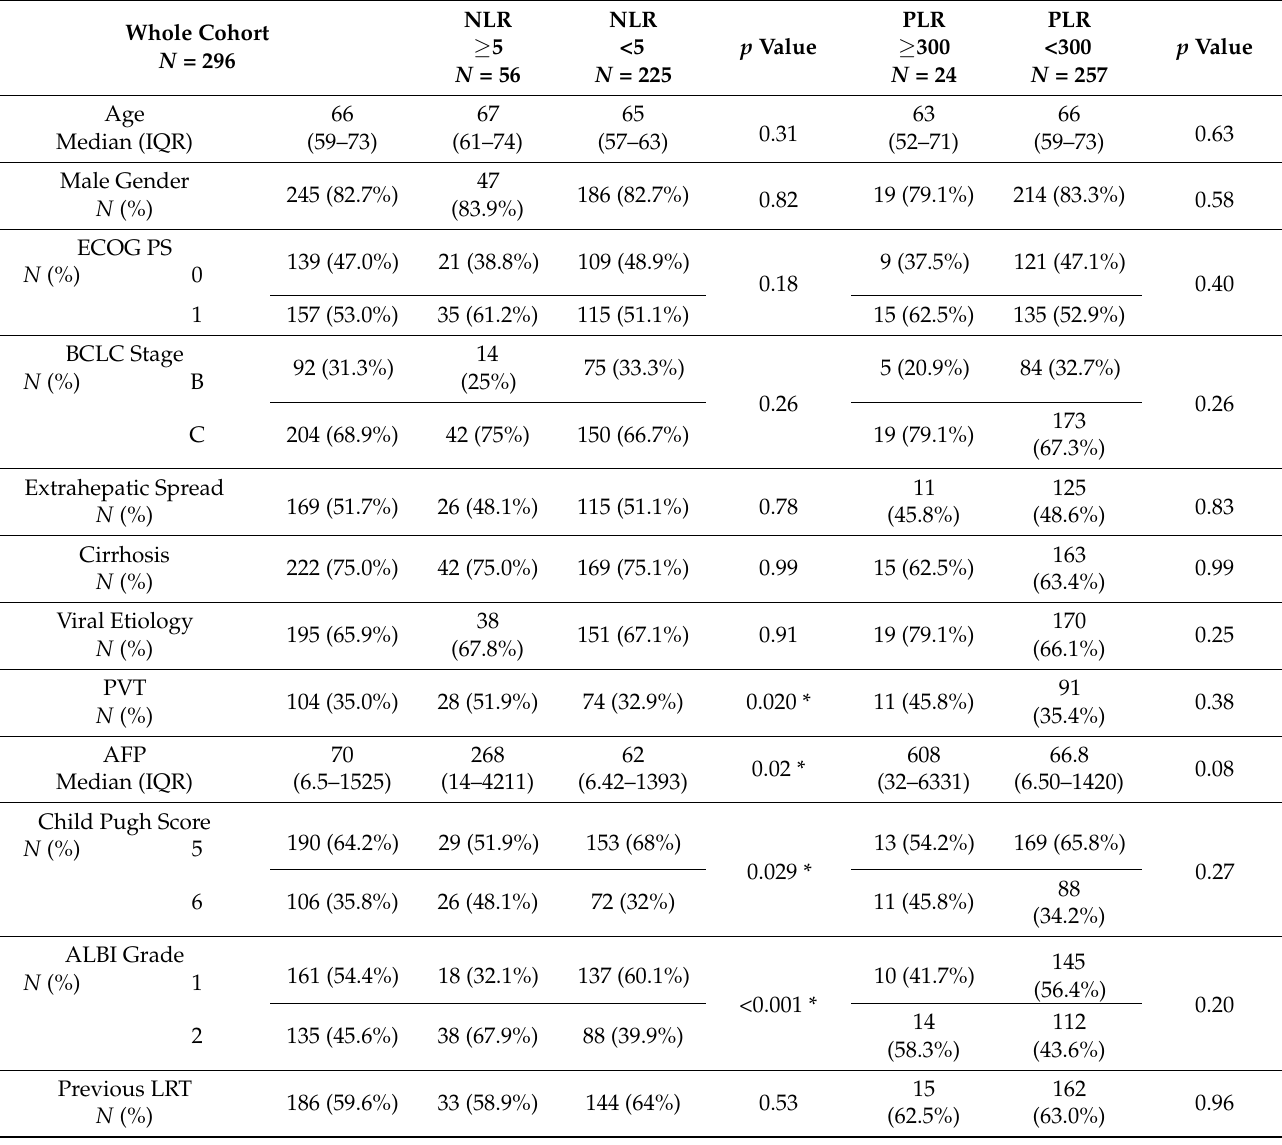
Table 1. Baseline